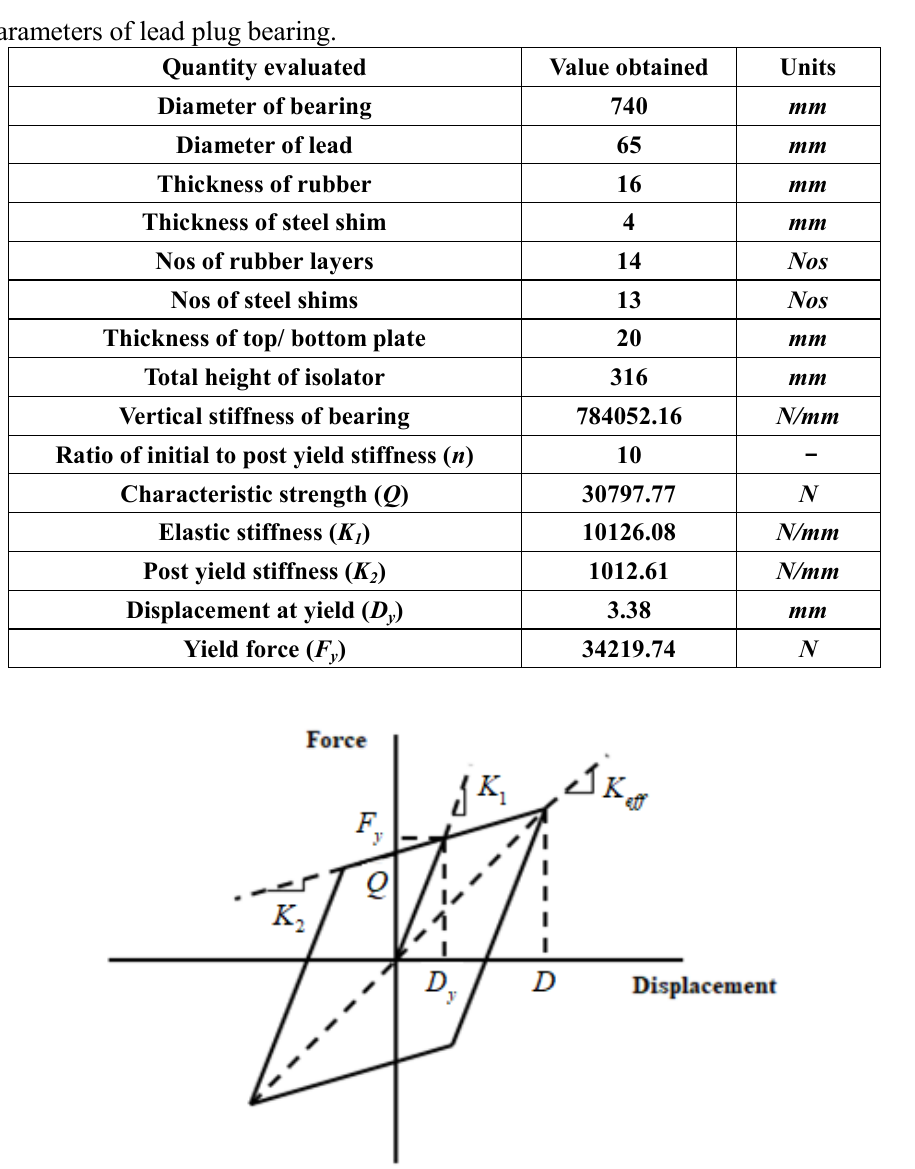
Fig. 6. Bilinear characteristics of LPB isolator